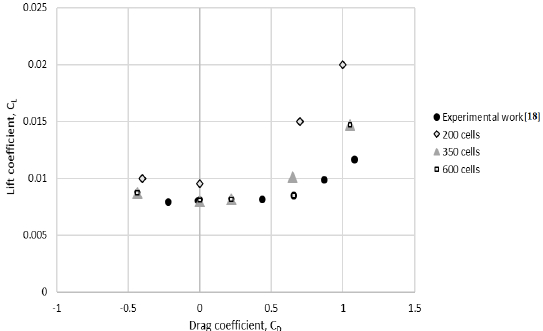
Figure 3. Suitability of cells around the cross–section of a blade.